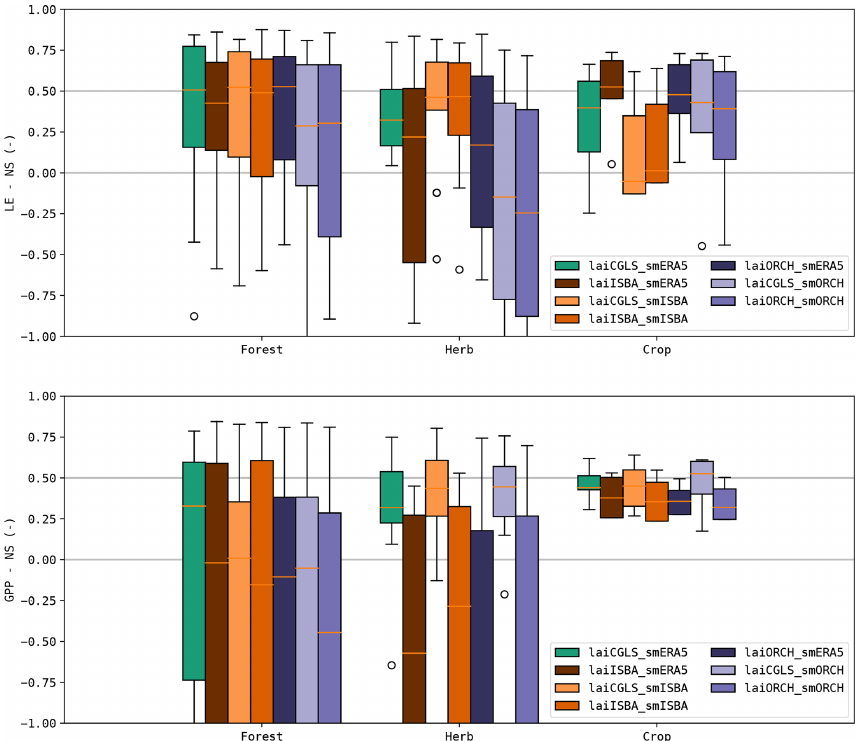
Figure 15. Nash–Sutcliffe model efficiency index of the DiagMod runs for the functional